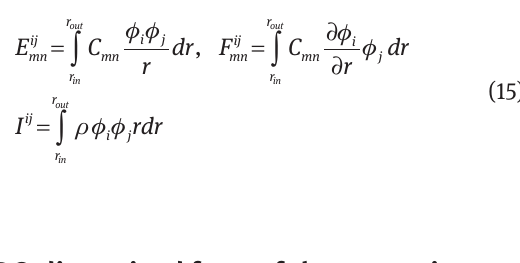
where the summation rule for dummy indices l and q is used. By substituting Eqs. (17a) – (17c) into Eqs. (16a) – (16c), a system of algebraic equations with 3 N ( N -2)( N -1) r z t equations and unknowns for each time sub-domain and for each circumferential wave number m , is derived. It is obvious that, the number of equations and unknowns are reduced to 2 N ( N -2)( N -1) for the case of axisymmet- r z t ric loading. By solving the systems of equations, the time histories of radial, tangential and axial displacements in each spatial point of the shell can be determined. Then, the strain and stress components are predicted in each point of the FG hollow cylinder in the computational time domain by using Eqs. (5) – (7). Four common types of boundary conditions at the ends of the FG shell ( z = 0, l ), which are considered in this study, are as follows: Clamped boundary conditions (C-C):